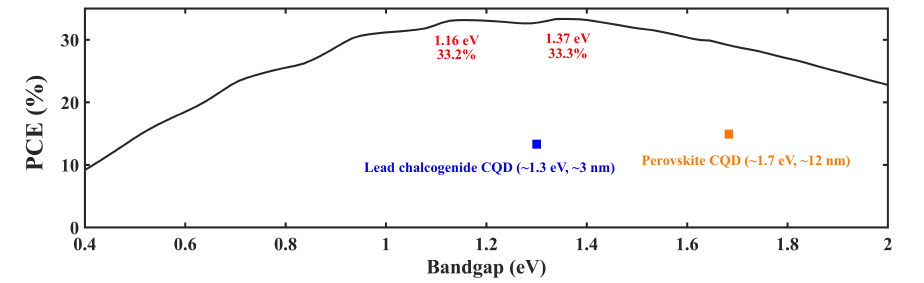
Figure 2. Shockley–Queisser limit: PCE vs. bandgap [11].